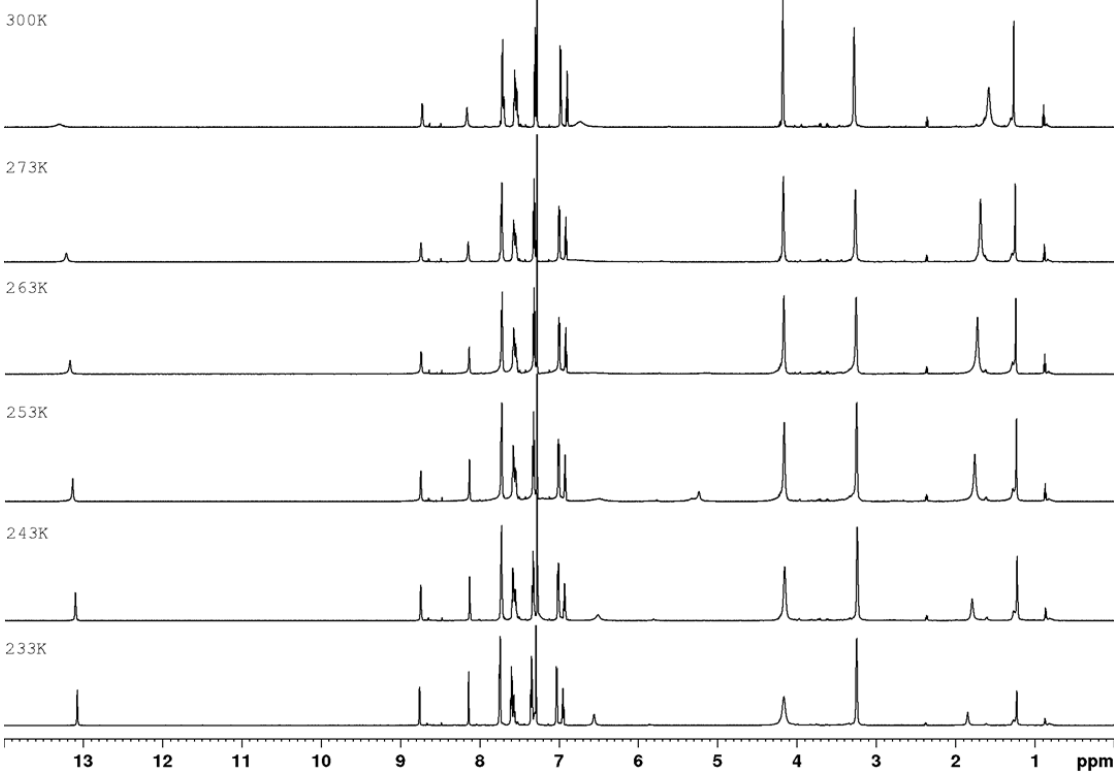
Figure 5. 1 H NMR spectra of 1c as a function of temperature (700 MHz, CDCl 3 ).